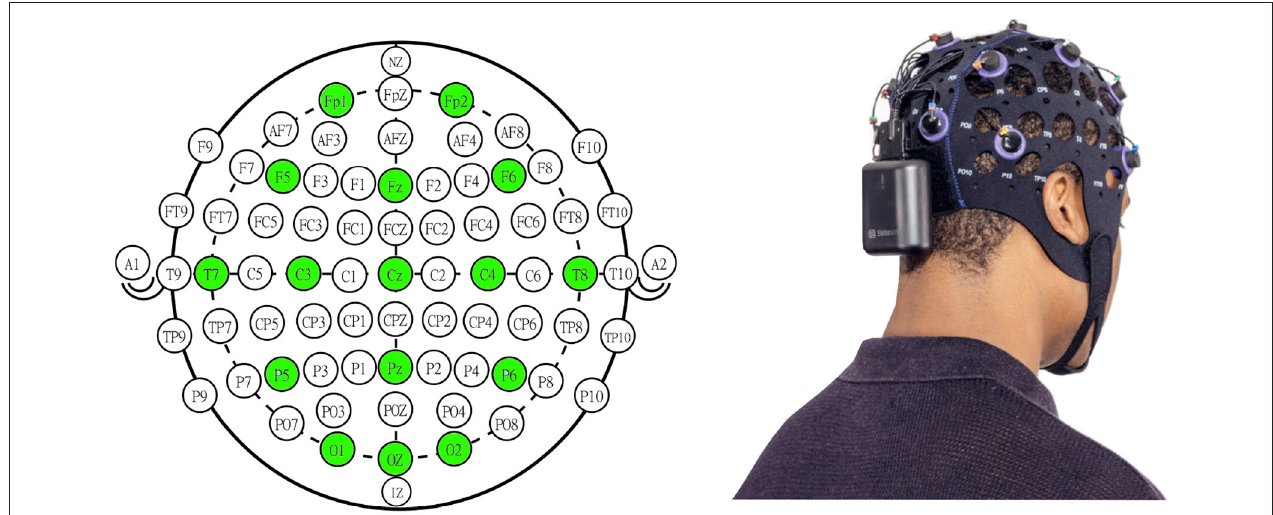
FIGURE 1 | (Left) Sixteen-channel montage used for the present study (in green) in the extended 10-20 International System. We selected this montage to evenly cover the scalp area. (Right) Versatile semi-dry EEG acquisition system utilized for the data capture. The system includes a Bluetooth acquisition module placed below the occipital area and an EEG headset with semi-dry electrodes. Please, note that the right panel image does not represent the actual montage used in this study and it was included to illustrate the acquisition system and